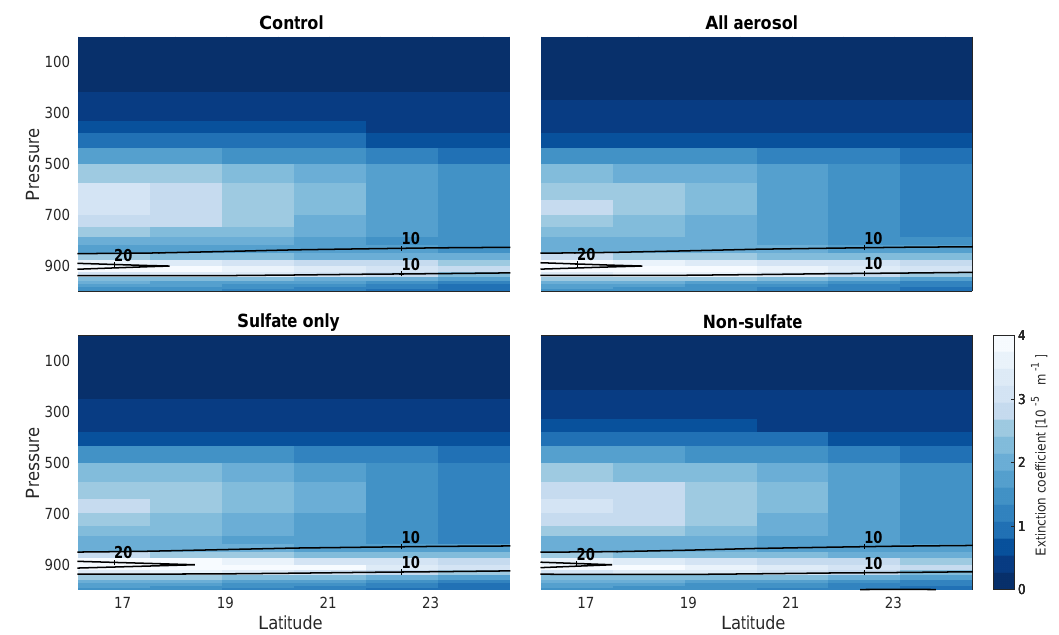
Figure 8. Vertical distribution of the aerosol extinction coefficient at 550nm (colour) and the cloud fraction in percent (contours) for the model MIROC in the Canarian